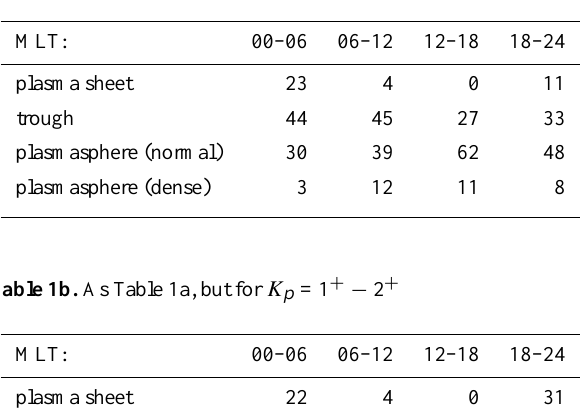
Table 1a. Occurrence probabilities (%) of plasma regions at L = 6.6